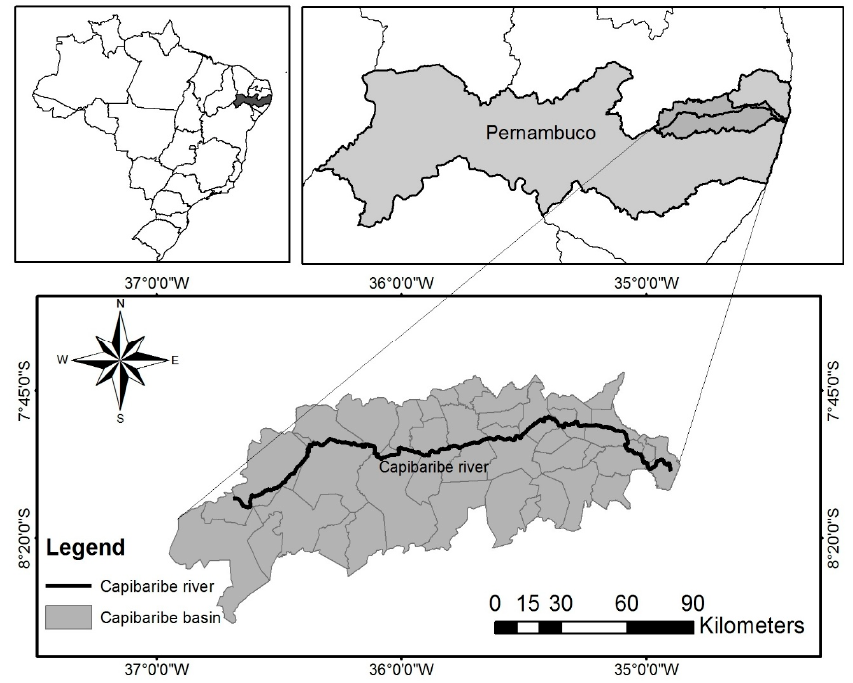
Figure 1. Location of the Capibaribe river basin and the area of water contribution of the Jucazinho reservoir.